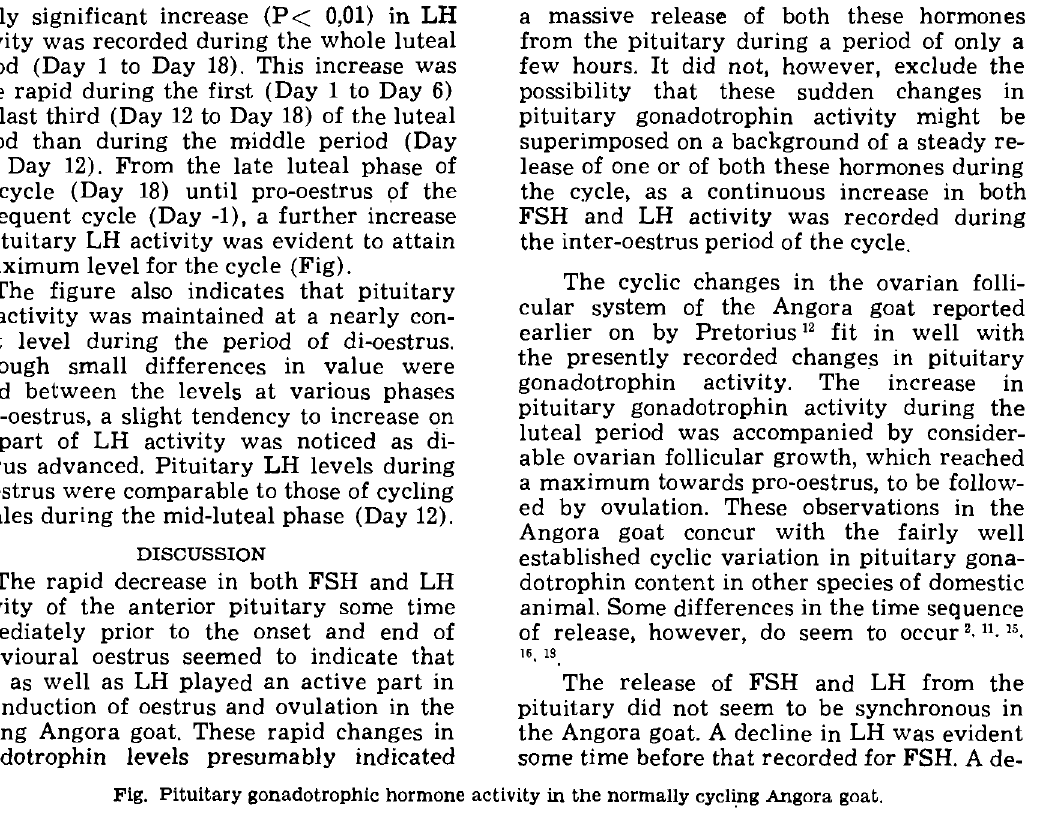
Fig, Pituitary gonadotrophic hormone activity in the normally cycling Angora